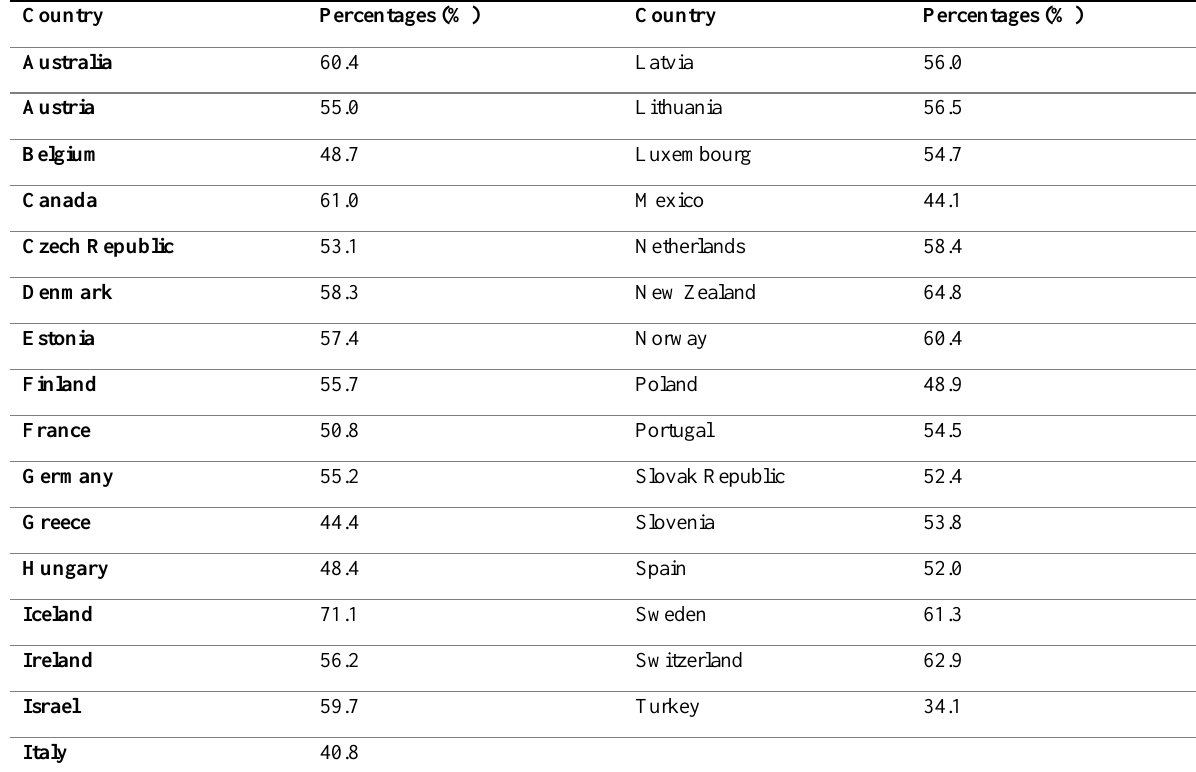
Table 4: Women Labour Force Participation Rates in OECD (15+) Country Percentages (%) Country Percentages (%)